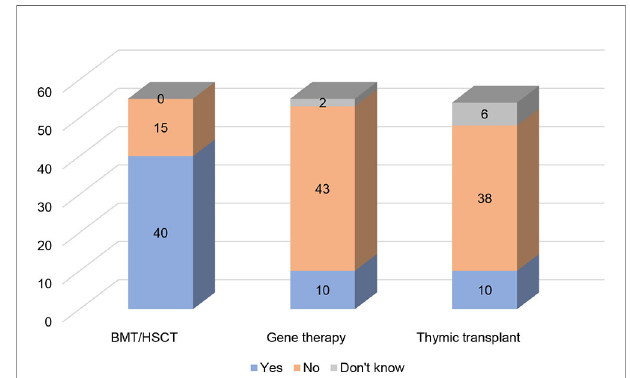
FIGURE 4 | Availability of HSCT, GT, and thymic transplant (n= 55,